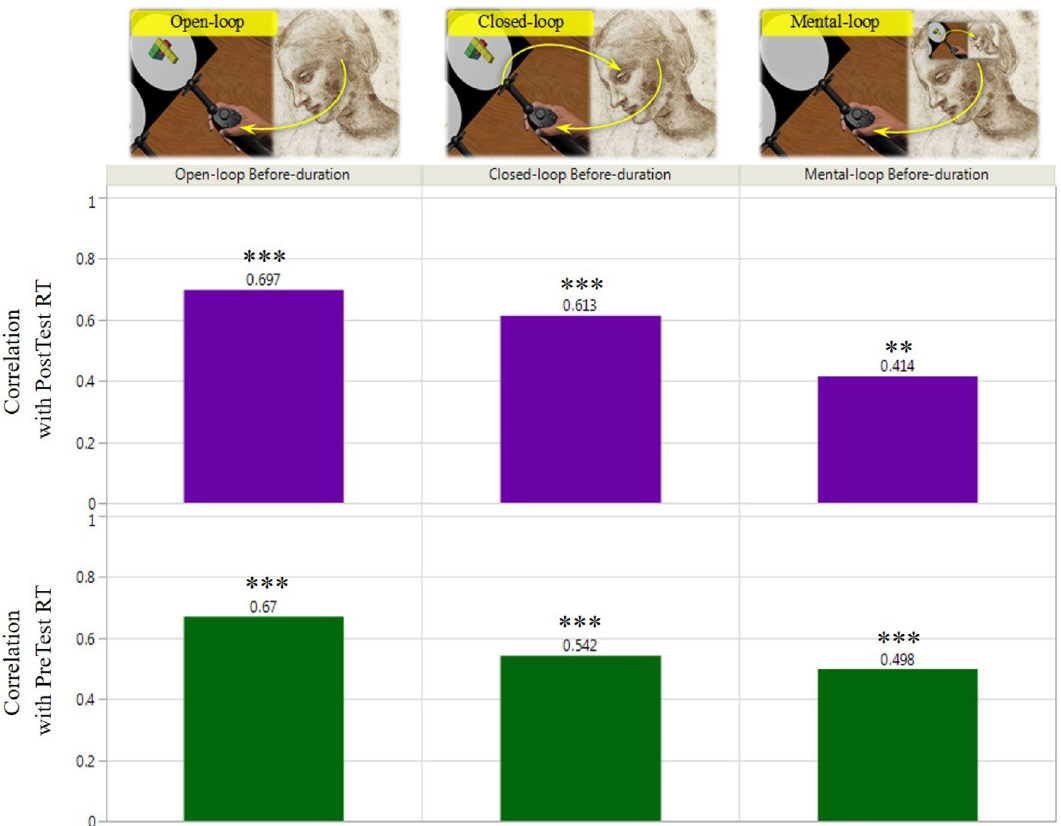
Figure 5. Inter-subject mental-motor capacity correlations. Pearson’s r correlations between individual average motor-planning and mental-rotation durations, per motor-control mode and mental-rotation pretest/posttest blocks (top). Statistical significance levels are denoted with